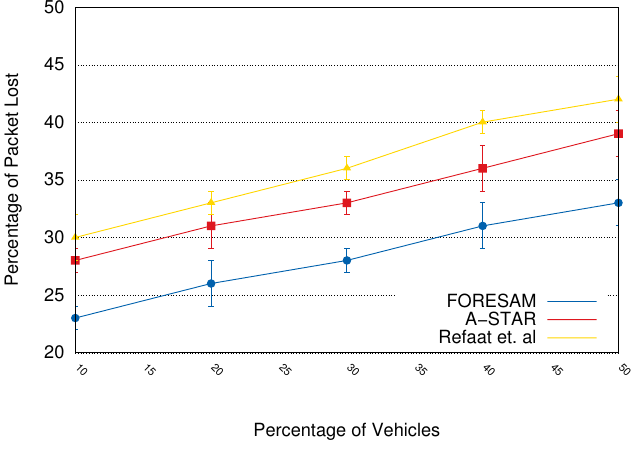
Figure 8. The percentage of packet